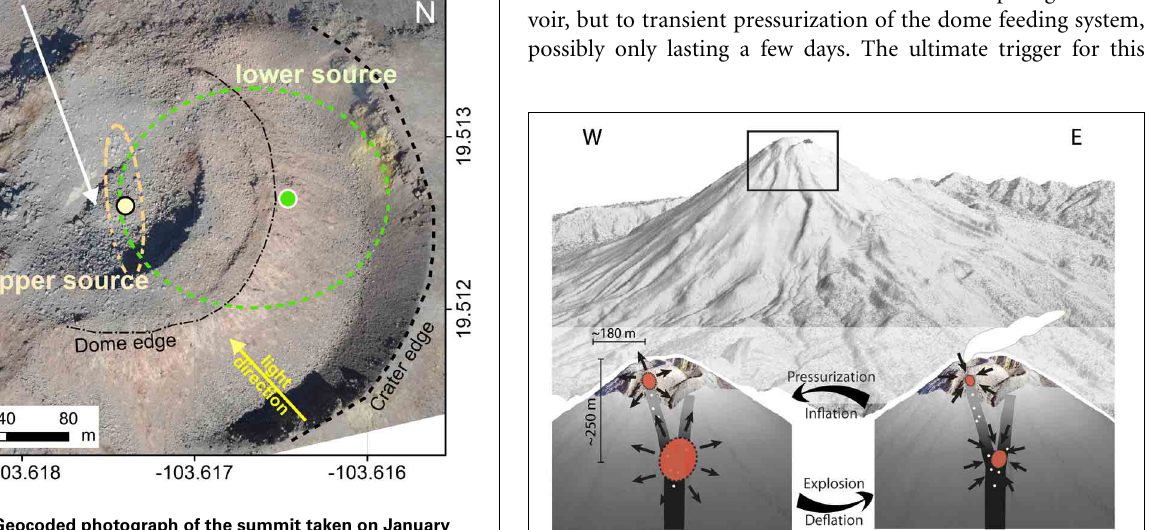
FIGURE 7 | Conceptual model. Transient pressurization at distinct locations of the conduit at Volcán de Colima. The sources are located in the uppermost region of the edifice. The depth of the lower source reflects the bifurcation of the conduit and presence of a plug, the upper source is located at the transition between the crater floor and the volcanic